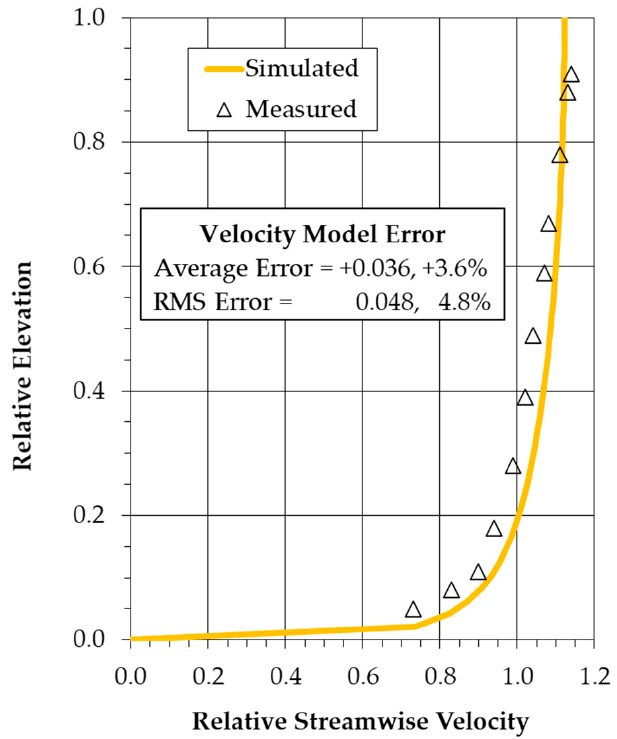
Figure 10. Comparison of simulated and measured velocity profile at cross-section S0 at position − 0.307 B.